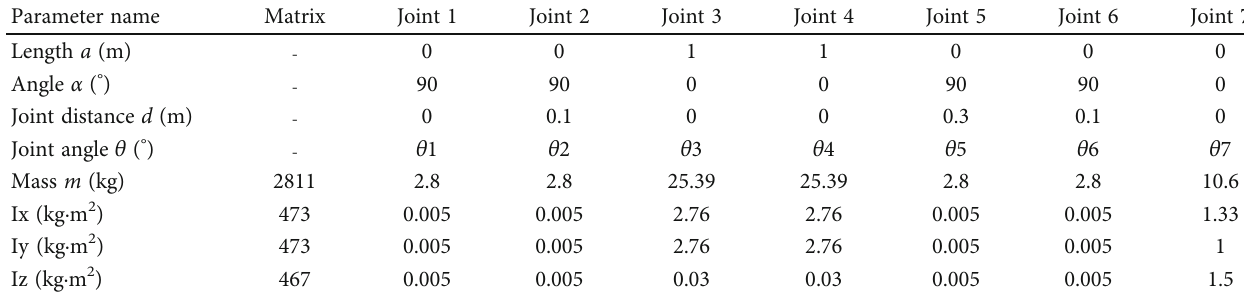
Table 1: Kinetic parameters.